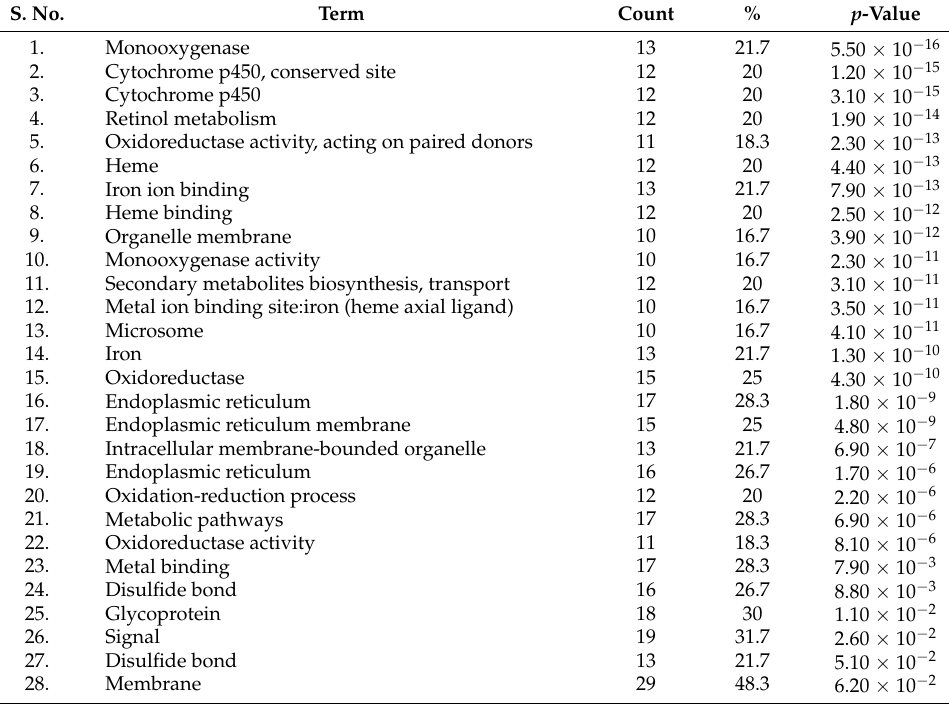
Table 3. Functional annotations of differentially expressed genes in HFLPD-fed animals compared to HFD-fed